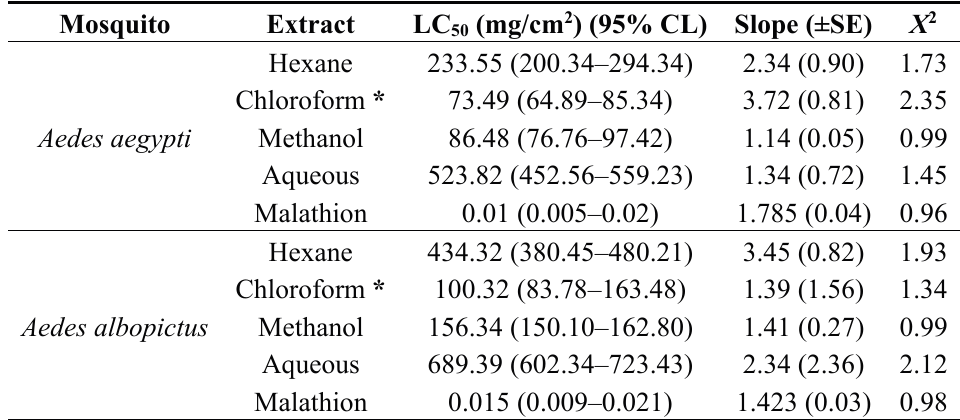
Table 4. Adulticidal activity of Bryopsis pennata extracts against female adult of Aedes aegypti and Aedes albopictus .